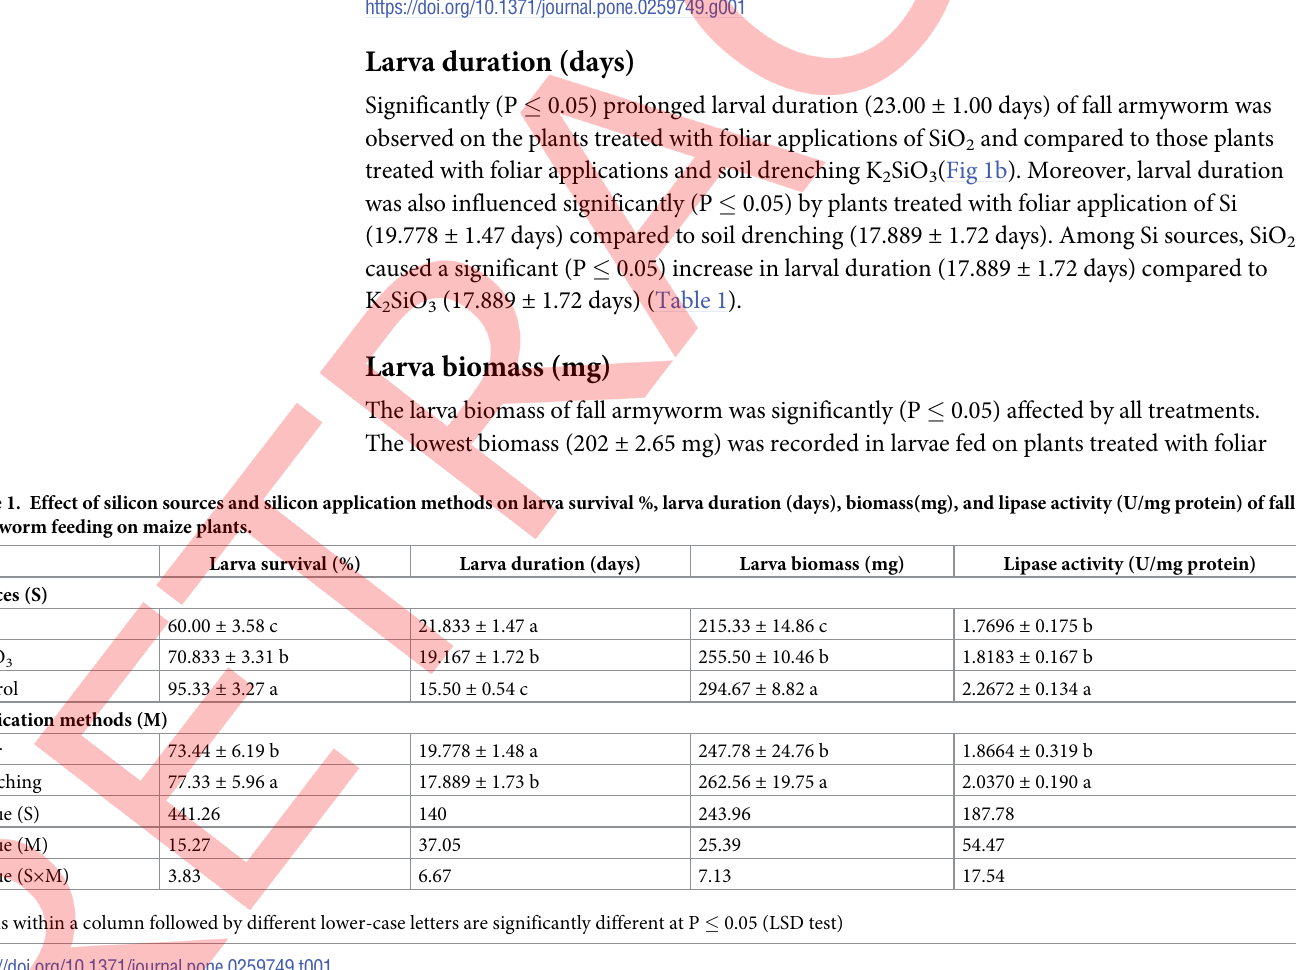
Fig 1. Effect of silicon sources and silicon application methods on (a) larva survival percentage, (b) larva duration (days), (c) larva biomass (mg), and lipase activity (U/mg protein) of fall armyworm. Means with different lower- case letters are significantly different; LSD test at p � 0.05. Vertical bars indicate SD.